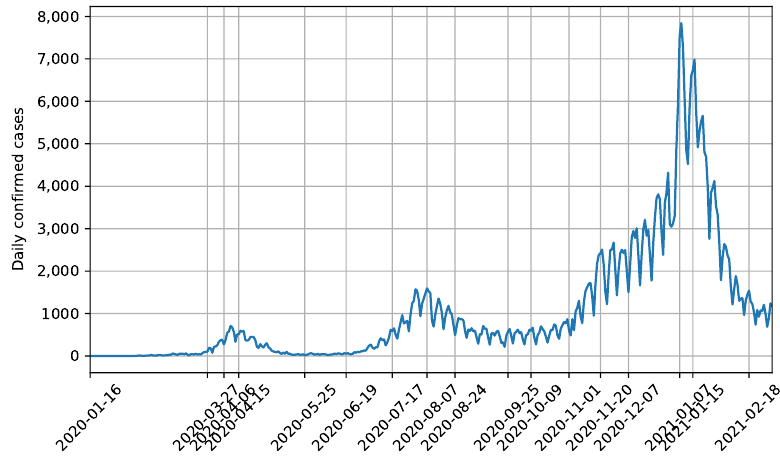
Figure 3. Segregation of the spread of COVID-19 in Japan for the modelling study.